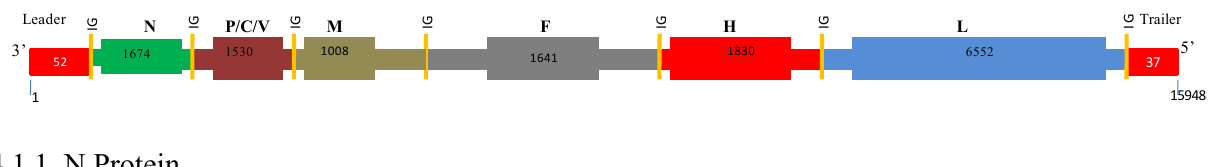
Figure 1. Genome organization of peste des petits ruminants virus